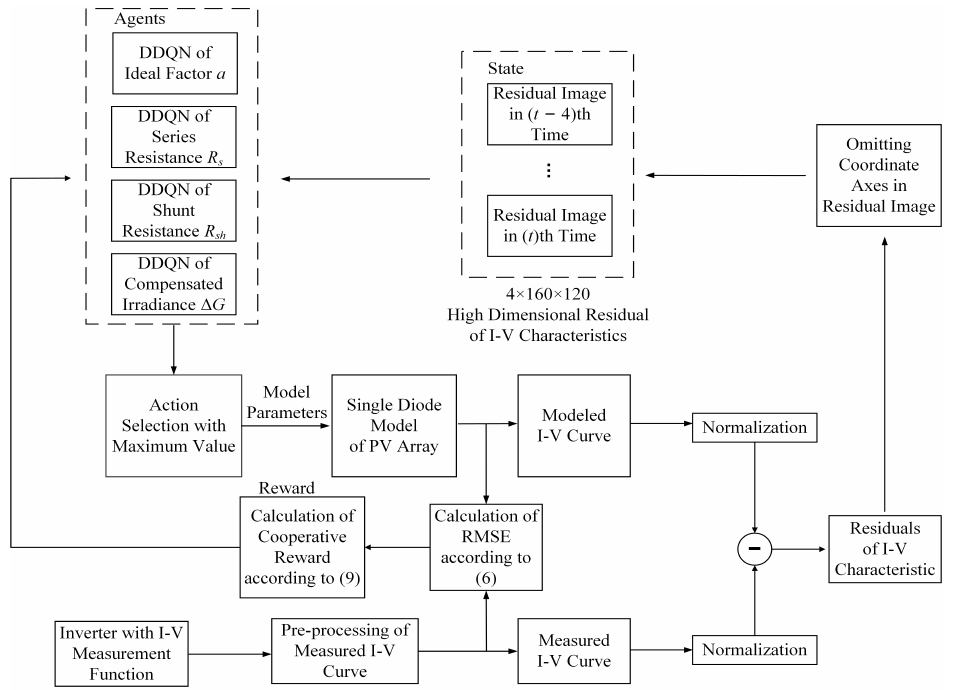
Figure 4. Framework of proposed multi-agent deep RL-based model parameter extraction of PV